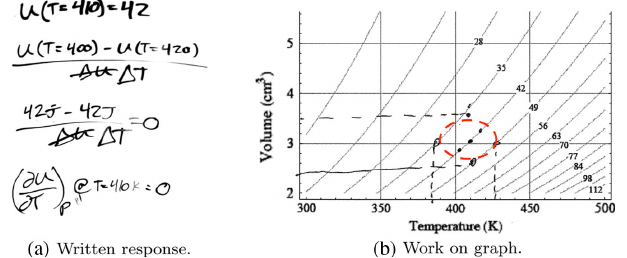
FIG. 14. Student 1 ’ s GA strategy for solving the problem. The dashed oval has been added to highlight the path of constant pressure that student 1